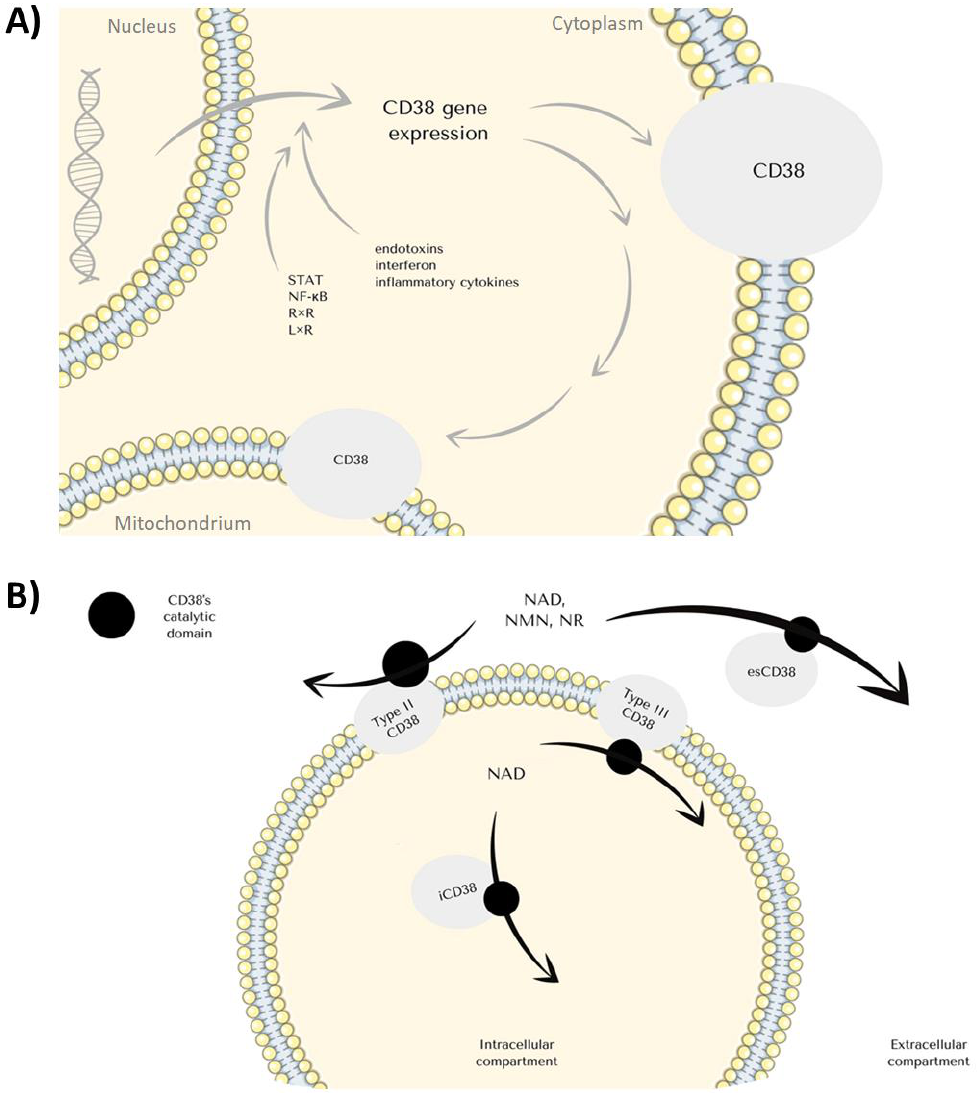
Figure 2. ( A ) Schematic representation of the factors that regulate the expression of the CD38 gene. It is worth noting that CD38 is localized both on the cell membrane and endoplasmic membranous system; ( B ) Schematic representation of the variety of CD38 types with their localization; STAT—signal transducer and activator of transcription, NF- κ B—Nuclear factor kappa B, RxR—retinoid X